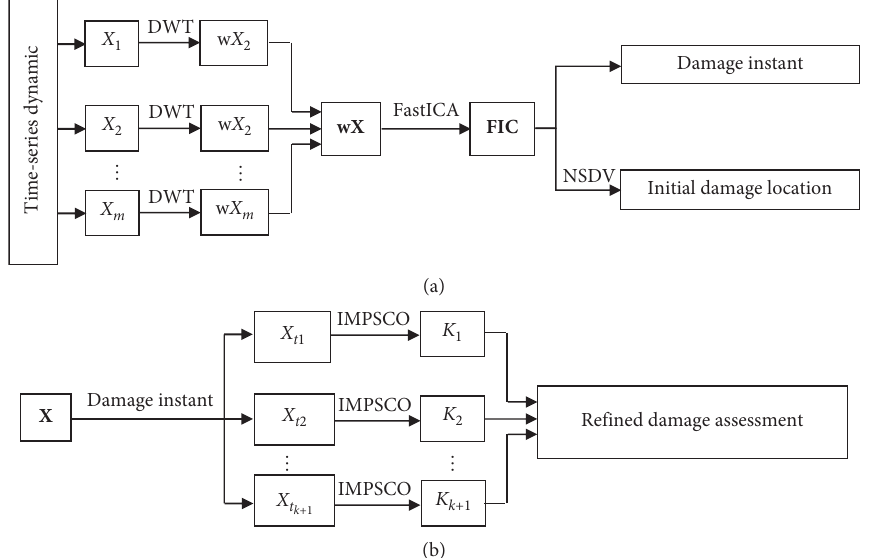
Figure 9: Two-stage sudden stiffness change of nonlinear structure detection strategy. (a) The first stage: primary damage assessment. (b) The second stage: refined damage